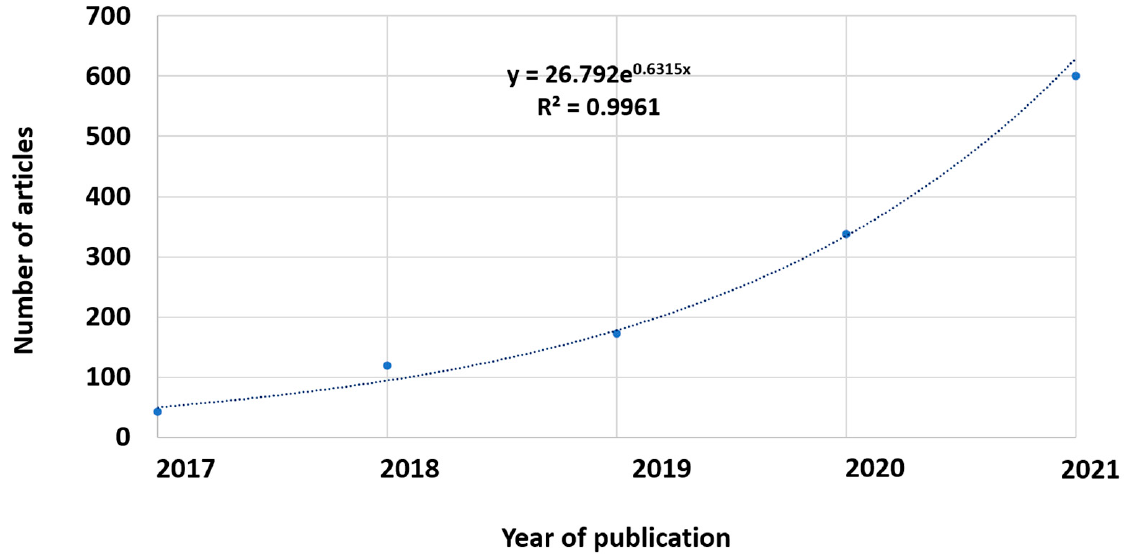
Figure 2. Quantity of annual publications on circular economy and foods during 2017–2021. Source: Authors’ elaboration.